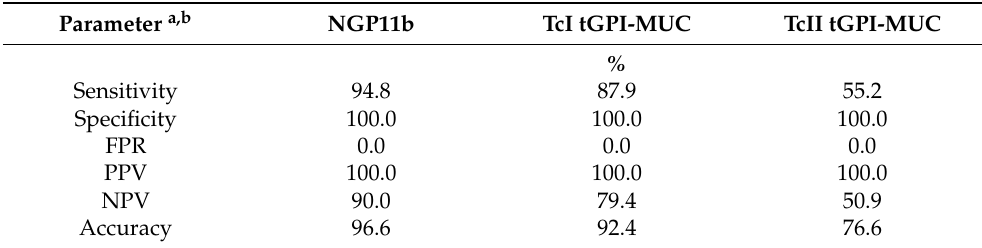
Table 2. Sensitivity, specificity, and other diagnostic parameters of NGP11b, TcI tGPI-MUC, and TcII tGPI-MUC, in the comparison of CCD vs. healthy individuals. Parameter